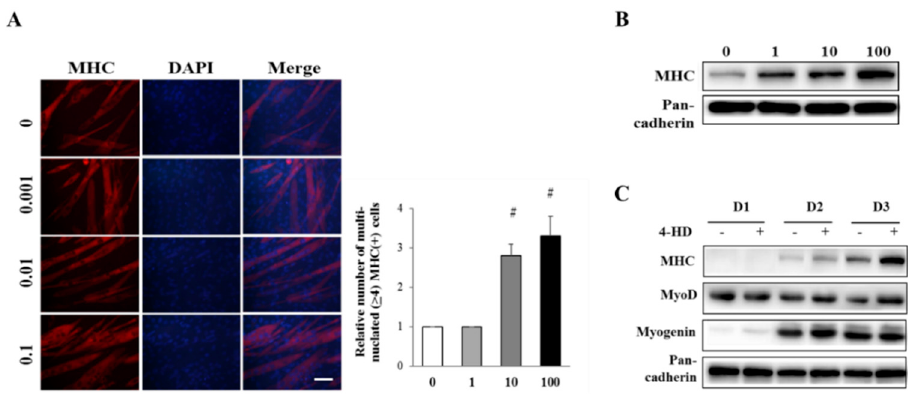
Figure 3. Effect of 4-HD on myogenesis of myoblasts. ( A ) Differentiated C2C12 cells in the presence of 4-HD (1, 10, 100 pM) were immunostained with antibody to MHC (red) and 4 ′ ,6-diamidino-2-phenylindole (DAPI, blue). Multinucleated (>4 nuclei) and MHC-expressing myotubes were counted from randomly selected areas. Scale bar = 200 µ m. # p < 0.005 vs. 0 nM. ( B ) Expression levels of MHC were determined by Western blotting analysis. ( C ) C2C12 myoblasts were treated with 4-HD (100 pM) during myogenesis period (D1, D2, D3) and levels of myogenic factors were measured by Western blotting analysis.